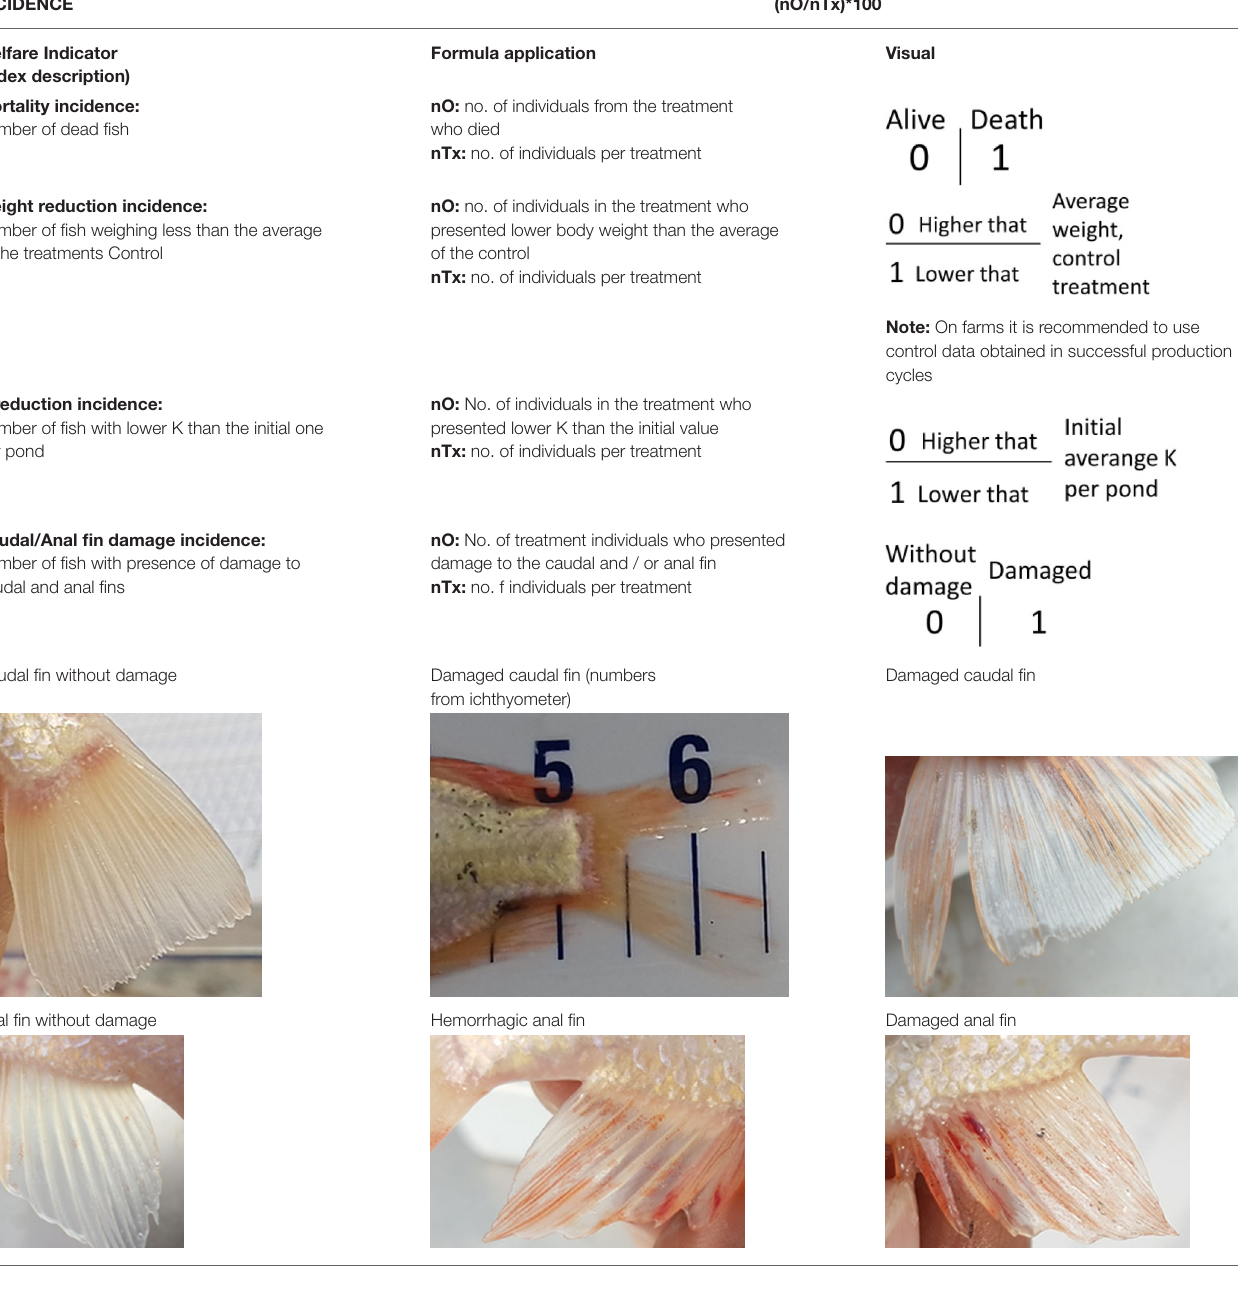
TABLE 2 | Description of the welfare indicator (index description) evaluated.